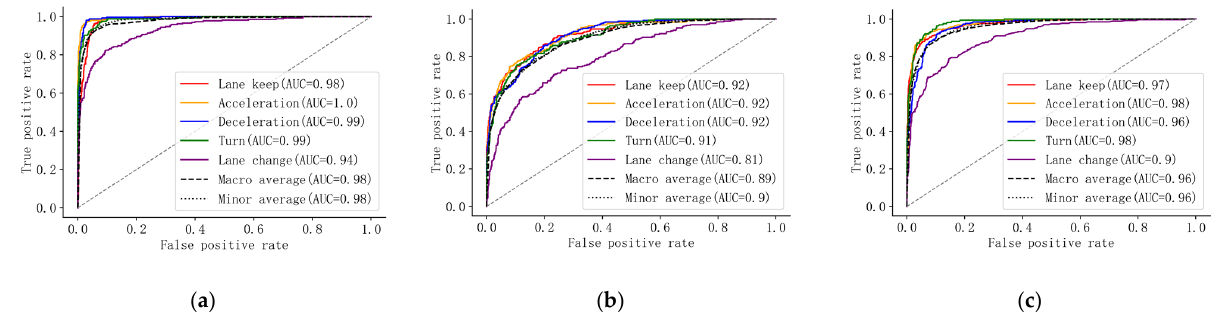
Figure 6. The ROC curve for each algorithm. ( a ) S-LSTM, ( b ) ANN, ( c ) XGBoost.